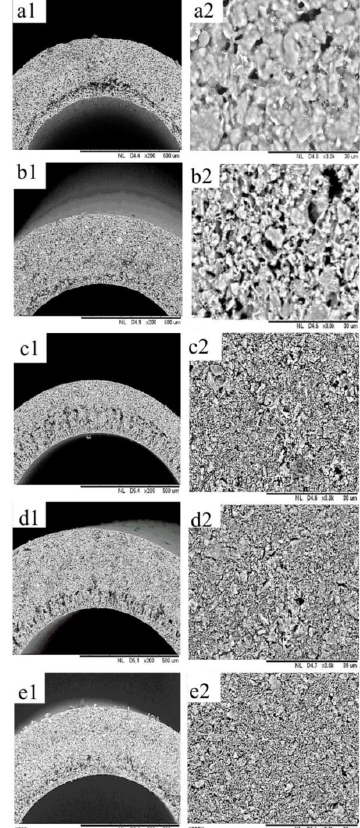
Fig. 3 SEM images of kaolin and kaolin/alumina hollow fibre membranes sintered at 1400 ℃ : (a) kaolin; (b) kaolin–alumina-1;